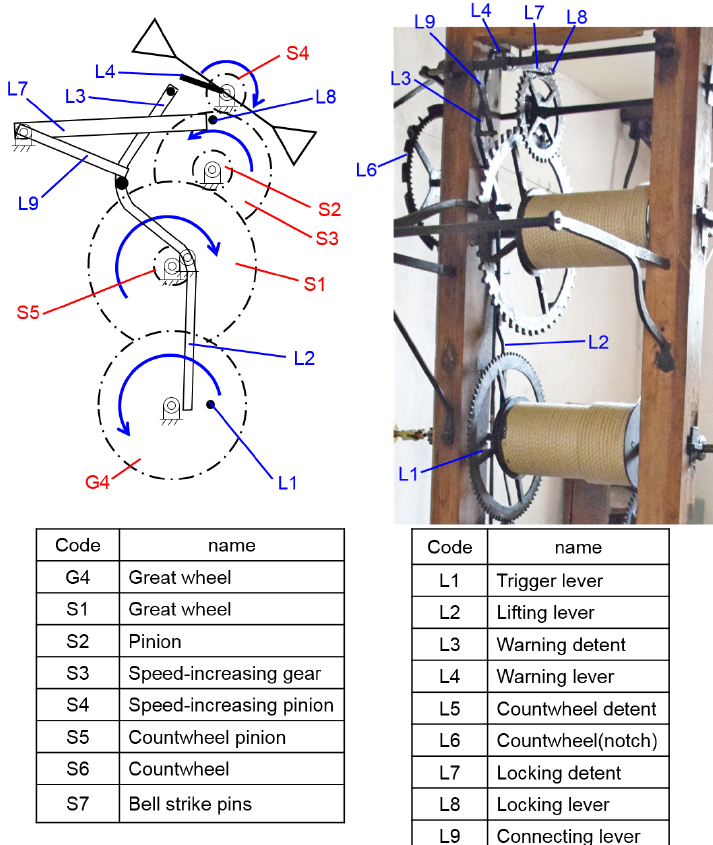
Figure 9. Striking train structure of the Metfield clock (N5) (Simon,